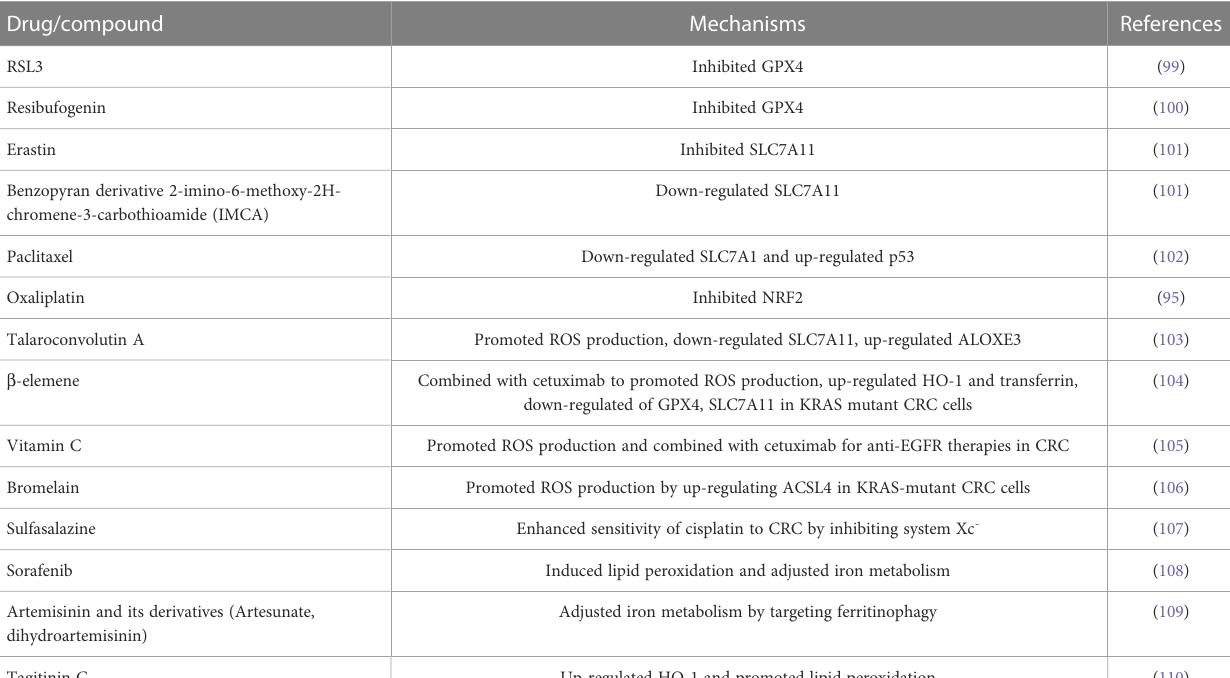
TABLE 1 Ferroptosis inducers for CRC